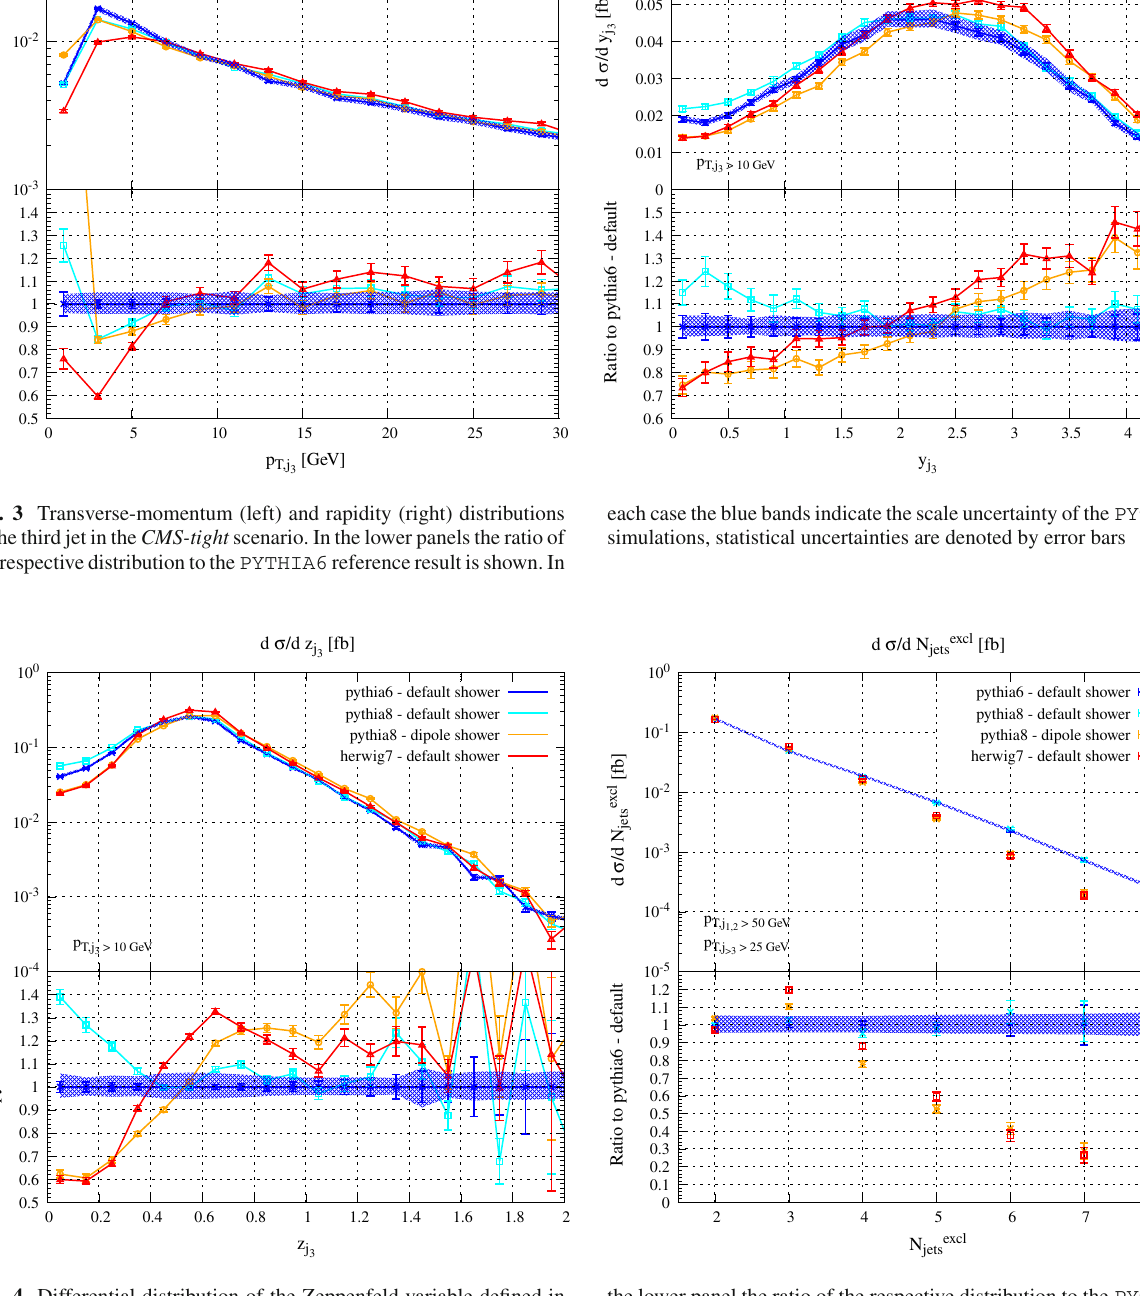
Fig. 4 Differential distribution of the Zeppenfeld variable defined in the lower panel the ratio of the respective distribution to the PYTHIA6 Eq. (18) (left) and the number of exclusive jets (right) in the CMS-tight reference result is shown. In each case the blue bands indicate the scale > 10 GeV and in the right plot scenario. In the left plot we require p T , j uncertainty of the PYTHIA6 simulations, statistical uncertainties are 3 werequirealljetsinadditiontothetwotagjetstohave p T > 25GeV.In denoted by error